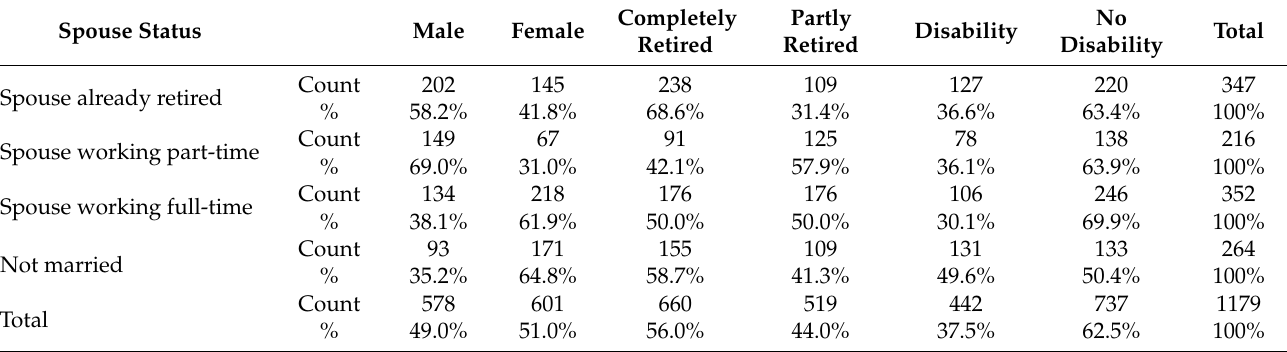
Table 4. Two-way contingency tables of gender, type of retirement and disability by spouse status.